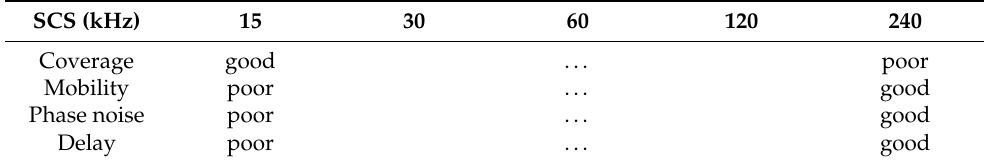
Table 1. Application performance of SCS in different frequency bands.